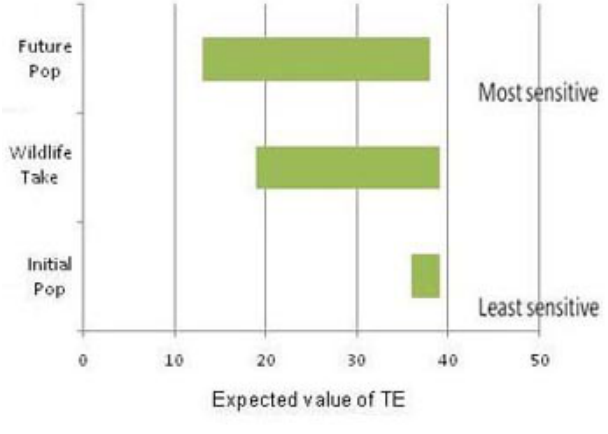
Fig. 6. Tornado diagram of one-way sensitivity analysis for the management decision